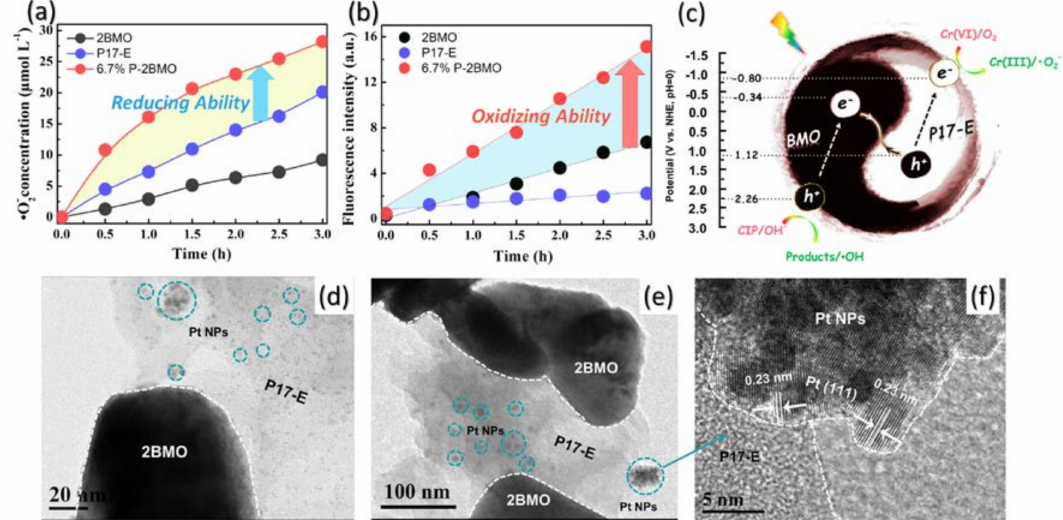
Figure 8. Quantitative determination of • O 2 – ( a ) and • OH ( b ) generation for 2BMO, 6.7% P-2BMO, and P17-E; ( c ) proposed photocatalytic mechanism of P-BMO according to Z-scheme electron transfer mode; ( d – f ) TEM and corresponding HRTEM images of 6.7% P-2BMO hybrid after in-situ photodeposition of Pt from H 2 PtCl 6